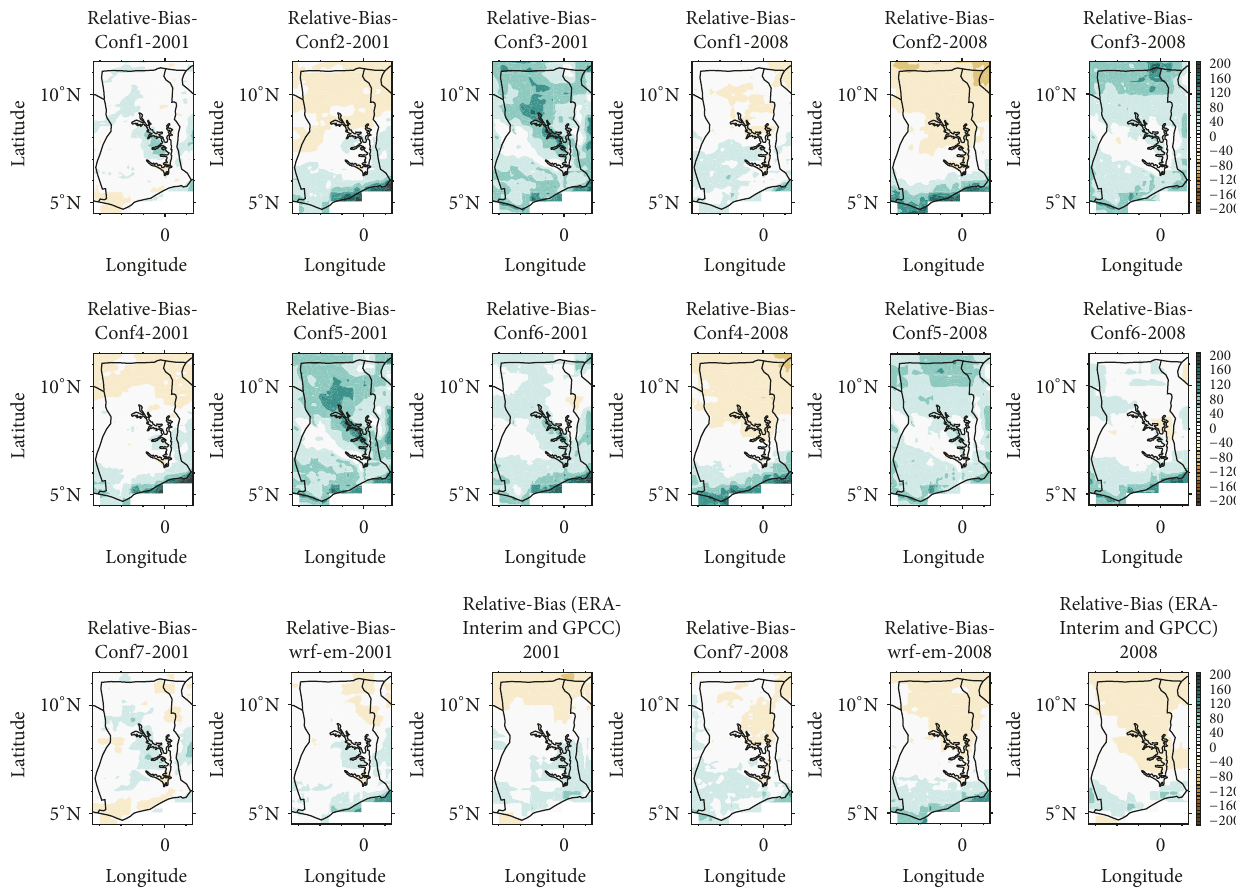
Figure 3: Relative bias (%) between all the configurations, ERA-Interim, and GPCC for the dry year (2001) and the wet year (2008)